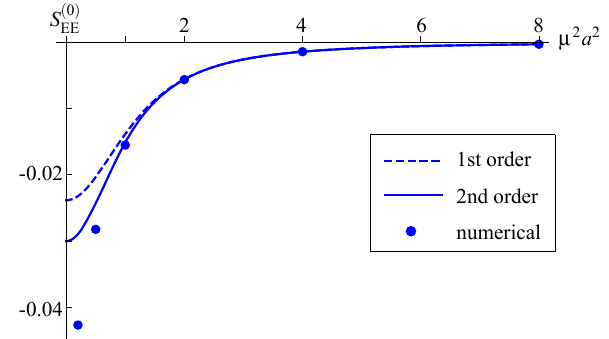
Fig. 4 The subleading constant term of entanglement entropy in scalar field theory in 3 + 1 dimensions, as function of the mass